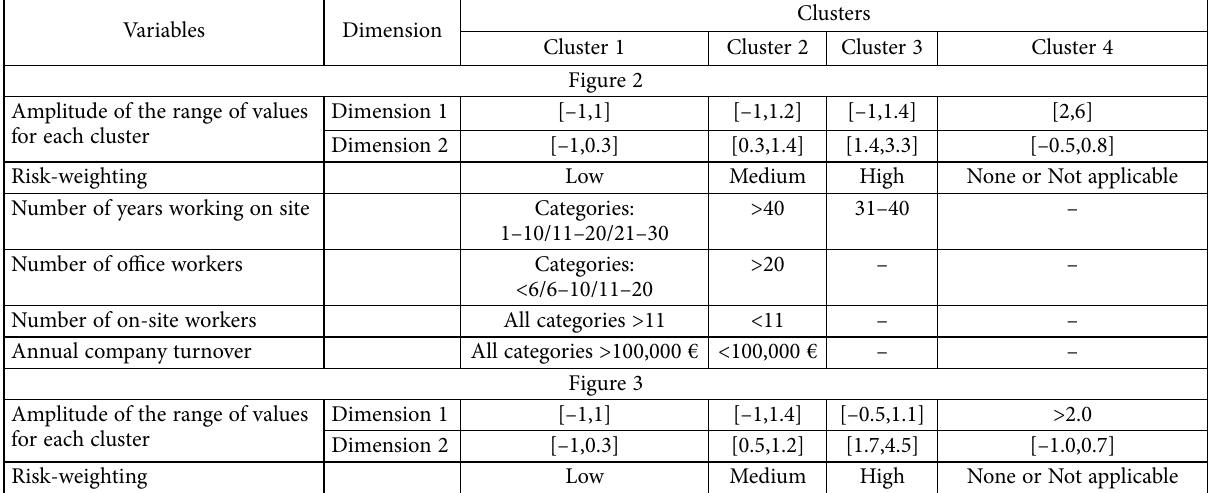
Table 5. Description of the characteristics of the clusters identified in Figures 2 and 3